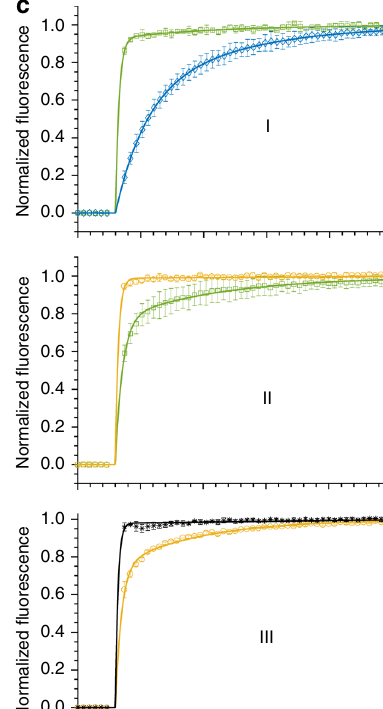
0 0.001 Fig. 6 Fine tuning of binding curves via the incorporation of mismatches in the displacement strand. a Modulating af fi nity via L DS alone leads to huge jumps in af fi nity. b In contrast, the incorporation of single mismatches into the displacement strand produces much more granular shifts in effective binding af fi nity. Mismatches are described such that 9_33 p6CG indicates that position 6, as de fi ned from the 3 ′ - end, was changed from C to G. Curves were averaged ( n = 3) and were fi t to and normalized by a single-site hyperbolic binding curve. Source data are provided as a Source Data fi le